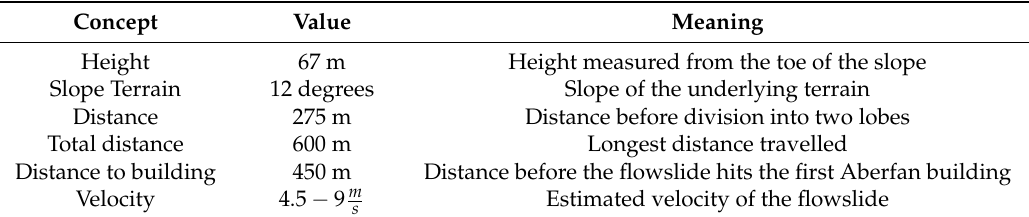
Figure 6. Map of Aberfan after the 1966 flowslide disaster (from UK National Archive).